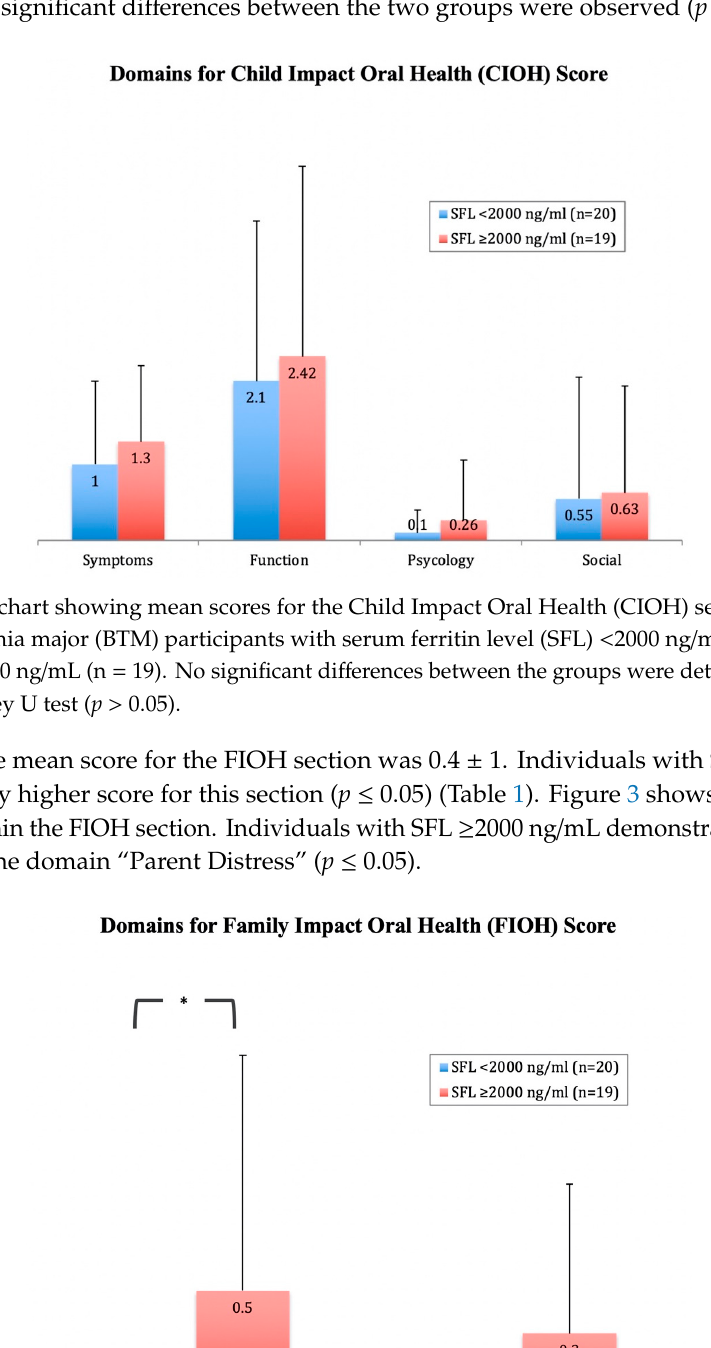
Figure 1. Stacked bar-chart showing the response percentages of the β -thalassemia major (BTM) participants with serum ferritin level (SFL) <2000 ng/mL (n = 20) and with SFL ≥ 2000 ng/mL (n = 19) to all 13 questions of the Early Childhood Oral Health Impact Scale (ECOHIS). No significant differences between the groups were detected using the chi-square test ( p > 0.05).